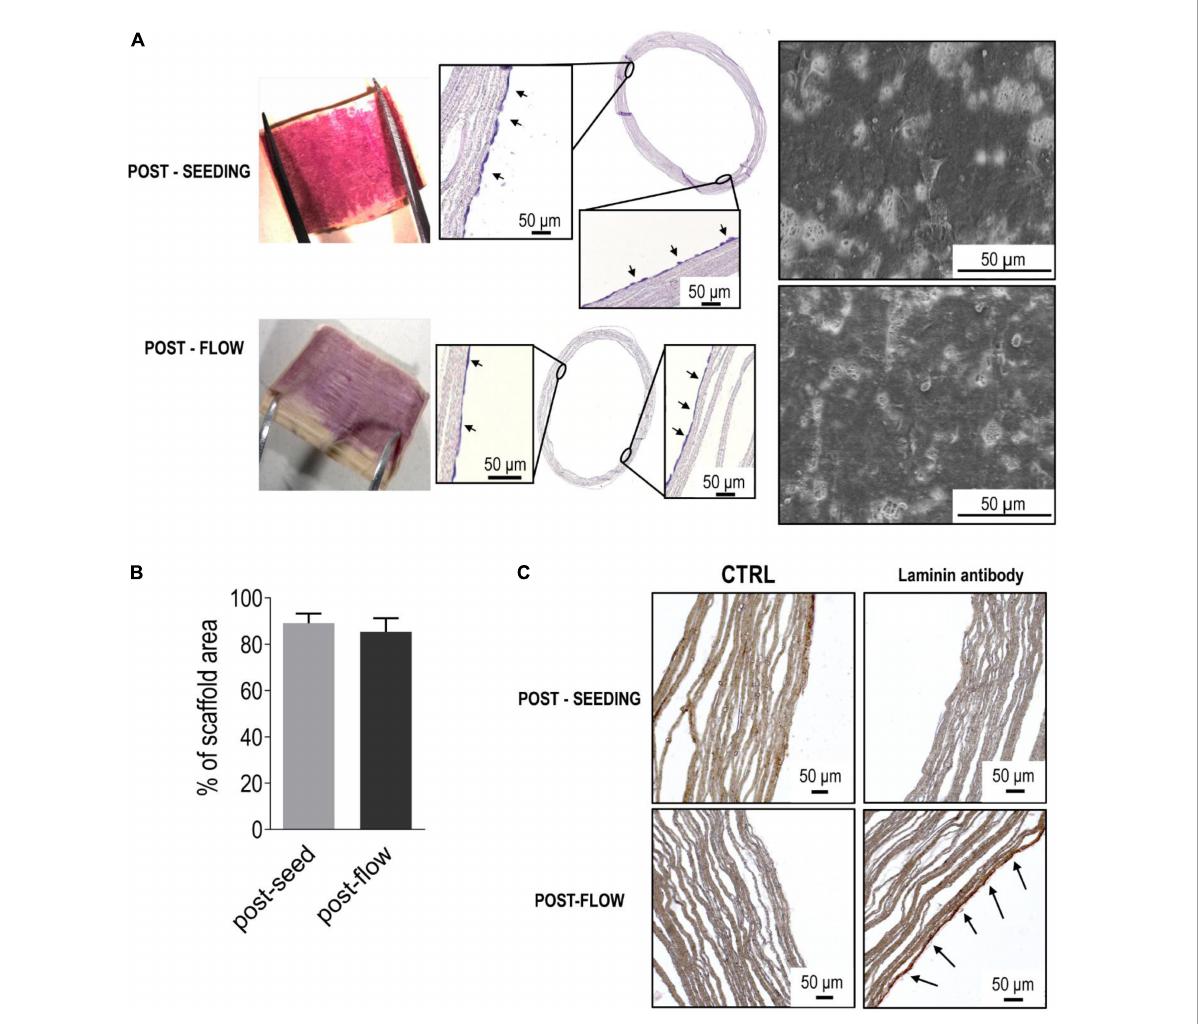
FIGURE3 Efficiency of the rotation-dependent ECs seeding and firm adhesion of ECs under a slow flow. (A) The picture on the top-left of the panel shows a nearly complete coverage by ECs of the luminal scaffold surface, as detected by MTT assay. The micrographs on the center and the right indicate, respectively, the structure of the EC layer in transversal section and the spreading of the cells onto the silk scaffold. Application of a constant flow (0.5 mL/min for 3 days), did not produce substantial modifications in the ECs coverage, neither at a macroscopic level (MTT staining and transversal sectioning), nor at a microscopic observation. This witnesses a good compatibility of the scaffold for firm adhesion of ECs resistant to application of a steady flow. Quantification of the area covered by ECs onto SEM micrograph showed that the cell coverage did not decrease in presence of a flow (B) , and that cells exposed to flow clearly synthesized a basal lamina, to reinforce their own firm adhesion (C)